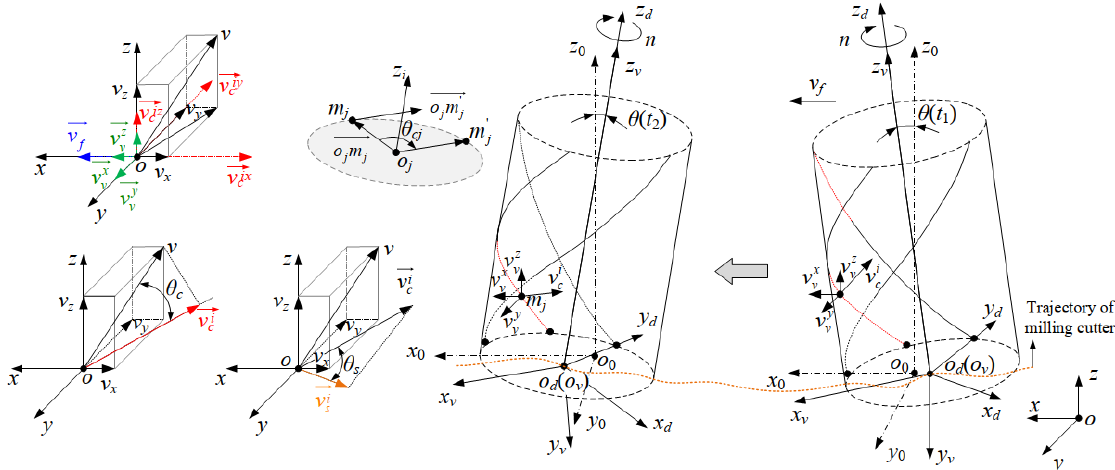
Figure 4. Velocity decomposition of synthetic cutting motion of cutting edge feature points. In Figure 4, v cix is the component of v ci on the x -axis. v ciy is the component of v ci on the y -axis. v ciz is the component of v ci on the z -axis. v vx is the component of the vibration veloc- ity on the x -axis. v vy is the component of the vibration velocity on the y -axis. v vz is the component of the vibration velocity on the z -axis.